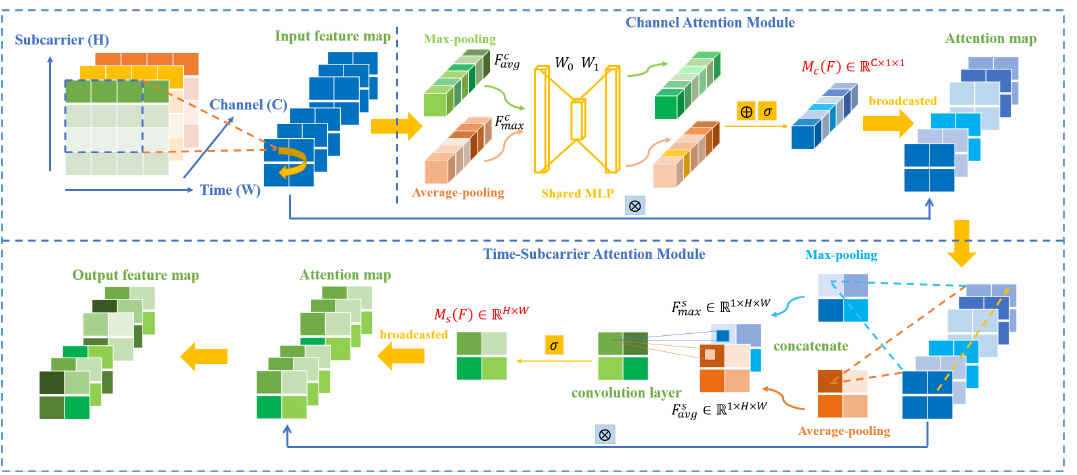
Figure 7. The structure of the channel attention module and the time–subcarrier attention module. σ denotes the sigmoid function. ⊗ denotes elementwise multiplication. ⊕ denotes elementwise